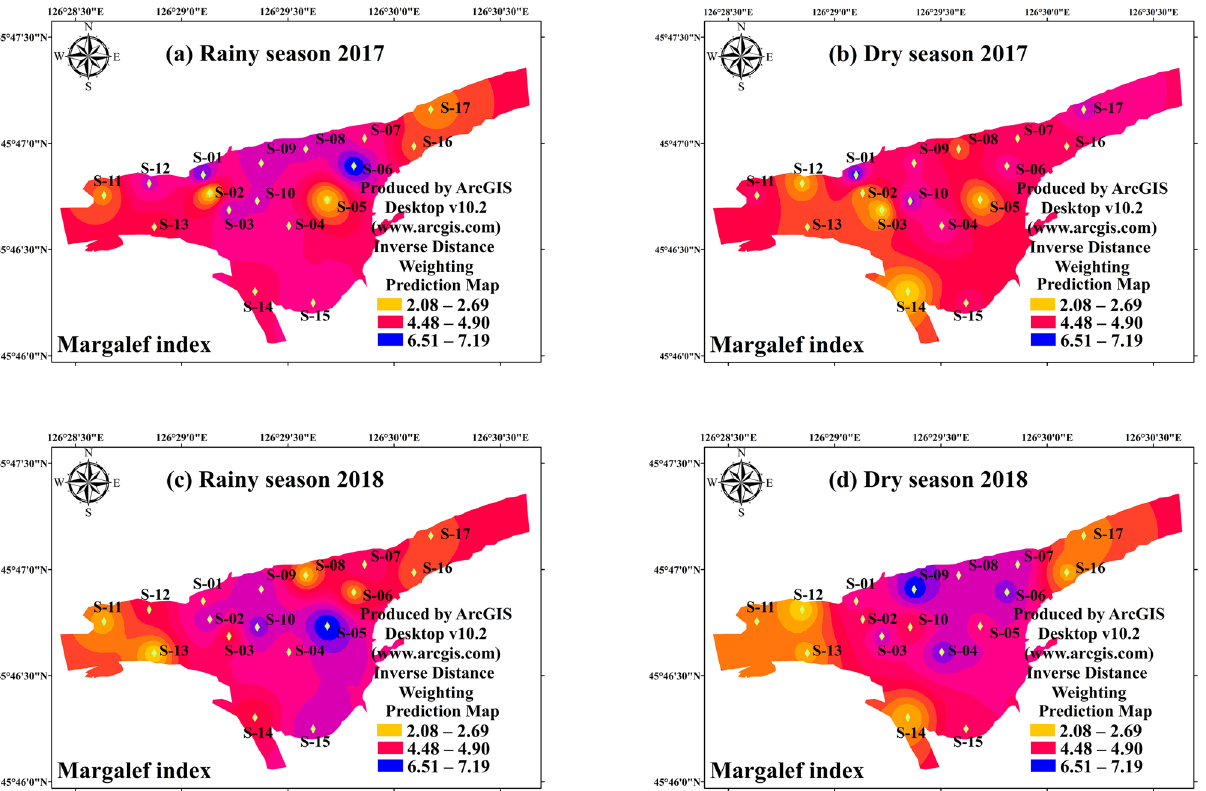
Figure 3. The spatial distribution of phytoplankton Margalef index in study period. ( a ) Rainy season (July 2017); ( b ) Dry season (October 2017); ( c ) Rainy season (July 2018); ( d ) Dry season (October 2018). The interpolation map was constructed by ArcGIS software using the Inverse Distance Weighting method. The maps were created using software ArcGIS Desktop v10.2 (www.arcgi concentrations increasing from the samples of river to wetland. These finding indicated that hydrological con- nectivity was a key factor in influencing the environmental variables variation in interconnected habits. An analysis of the spatial and temporal variations of total TSI (the combination of the TSI for TP, TN, COD, and Chl-a) was performed (Fig. 2). TSI indicated that trophic states of the study area ranged from mesotrophic to highly eutrophic (Table 1, Fig. 2). There was significant change between rainy season and dry season of the total TSI (Table 1) ( p < 0.01). The mean TSI in rainy season was 56 ± 8, significantly lower than that in dry season (mean TSI 63 ± 7) ( p < 0.01). As a whole, in dry season, the eutrophication state was more serious in rainy sea- son, when a high trophic state occurred in widespread areas of the Harbin Section of the Songhua River. Based on environmental variables pattern and TSI, we found that hydrological connectivity was a vital component of ecological process that influenced the trophic state in interconnected habits of Songhua River Basin. Temporal-spatial variations of phytoplankton diversity indices. A total of 221 species of phyto- plankton belonged to 8 phyla and 79 genera were identified, including Chlorophyta (43.89%), Bacillariophyta (26.24%), Cyanophyta (16.74%), Euglenophyta (9.05%), Pyrrophyta (2.26%), Cryptophyta (0.90%), and others (0.45%). Phytoplankton abundance ranged from 0.13 × 10 6 ind./L to 244.67 × 10 6 ind./L during the study period. There was no significant variation of phytoplankton abundance in different hydrological period ( p > 0.05) (Table 2). Nevertheless, phytoplankton abundance showed significantly spatial heterogeneity in the two habitats ( p < 0.01), with higher values in sample sites of wetland and lower values in river (Table 2). Overall, Cyanophyta and Bacillariophyta were co-dominant in study period, which contributed more than 80% total phytoplankton abundance (mean 26.37 × 10 6 ind./L and 12.87 × 10 6 ind./L, respectively) (Table 2). There was significant variation between the hydrological period and habits on the Margalef index during the study period. The results of T-test showed that the hydrological period ( p < 0.05) and habits ( p < 0.01) differences were both significant (Table 2). The Margalef index of the interconnected aquatic habits was 4.01 ± 0.99 in dry season and 4.84 ± 1.37 in rainy season, respectively (Fig. 3). The mean value of Margalef index of the wetland